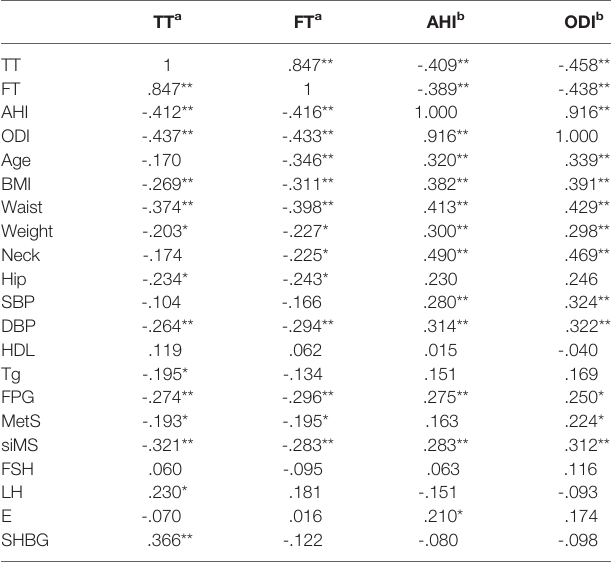
TABLE 2 | Correlation matrix between testosterone, free testosterone, AHI, ODI and general characteristics of patients. TT a FT a AHI b ODI